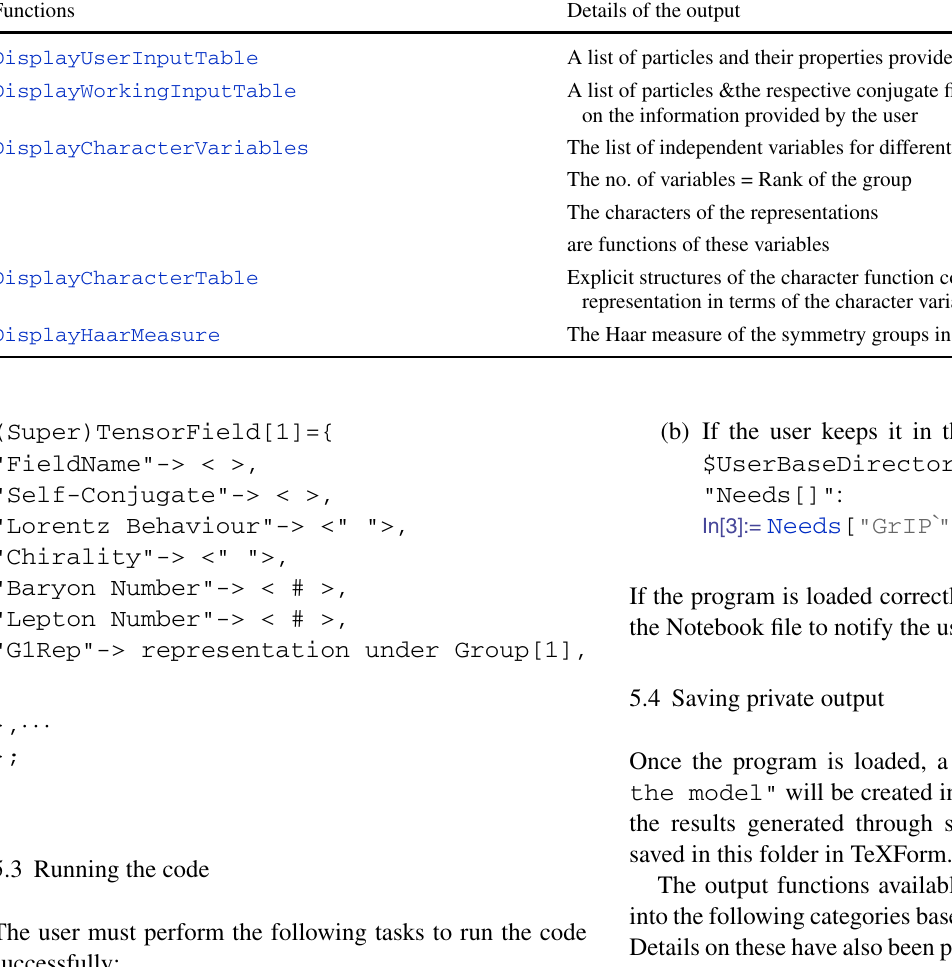
Table 12 Different output functions of GrIP and their details